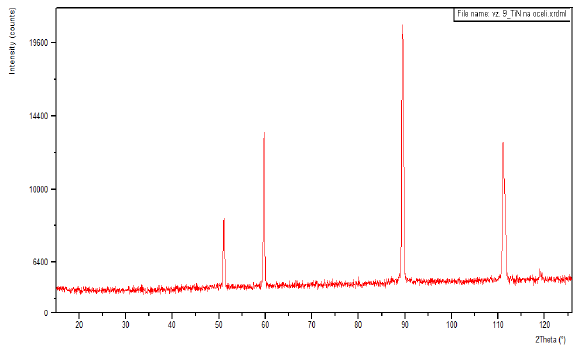
Figure 6. XRD patterns obtained with sample K9